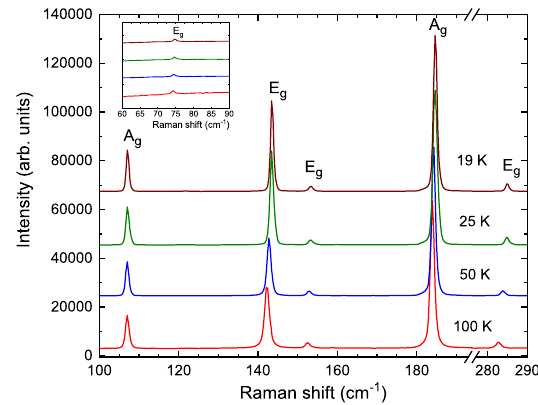
Fig. 4 The Raman spectra of CrBr 3 . The Raman spectra, measured at selected temperatures. The inset shows enlarged sections of the spectra in the Raman shift region of 60 – 90cm − 1 .